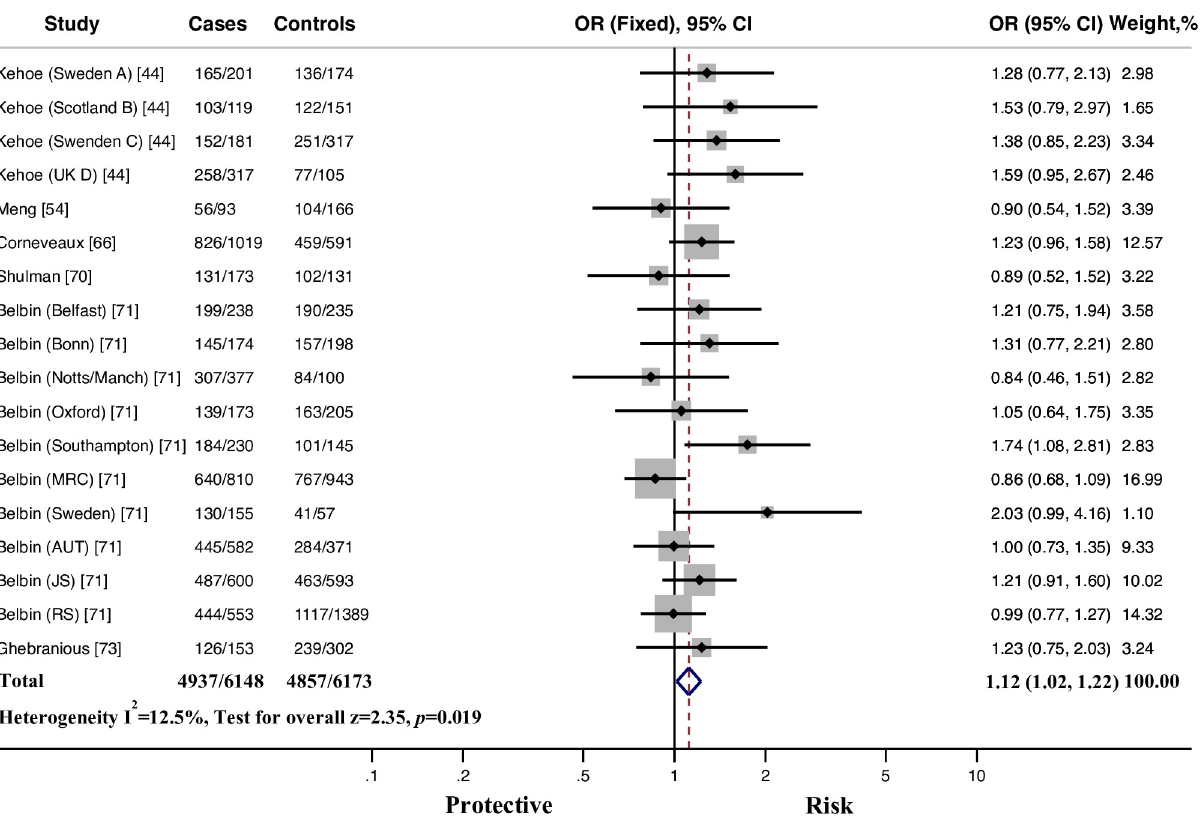
Fig 5. Fixed-effects odds ratio (OR) for the association of ACE rs1800764 T / C polymorphism AD susceptibility in populations of European descent ( TT+TC vs CC ). The size of the gray box is proportional to the weight of the corresponding study. The pooled estimate is displayed as a diamond. Bars, 95% confidence interval